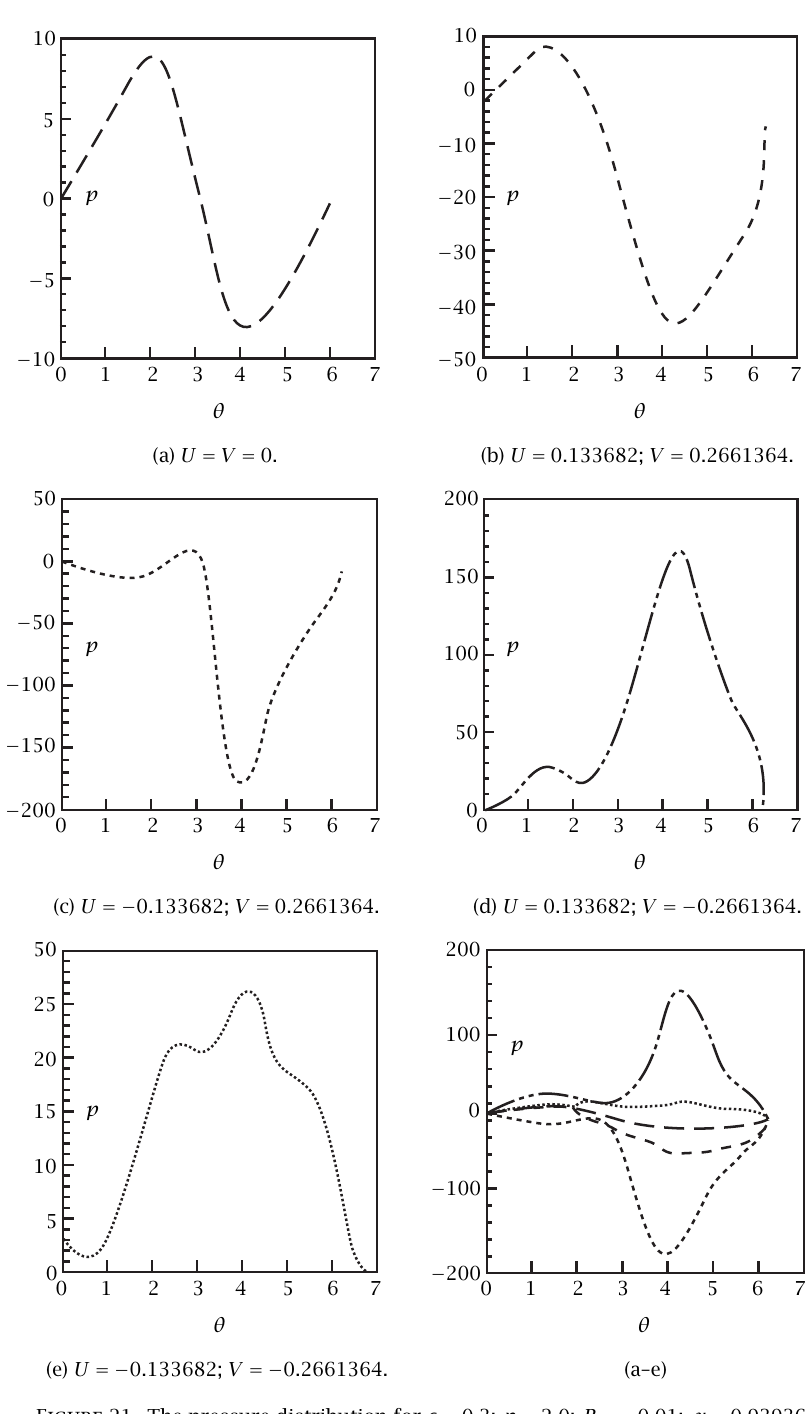
Figure 21 . The pressure distribution for (cid:9) = 0 . 3; η = 2 . 0; R M = 0 . 01; α = 0 .